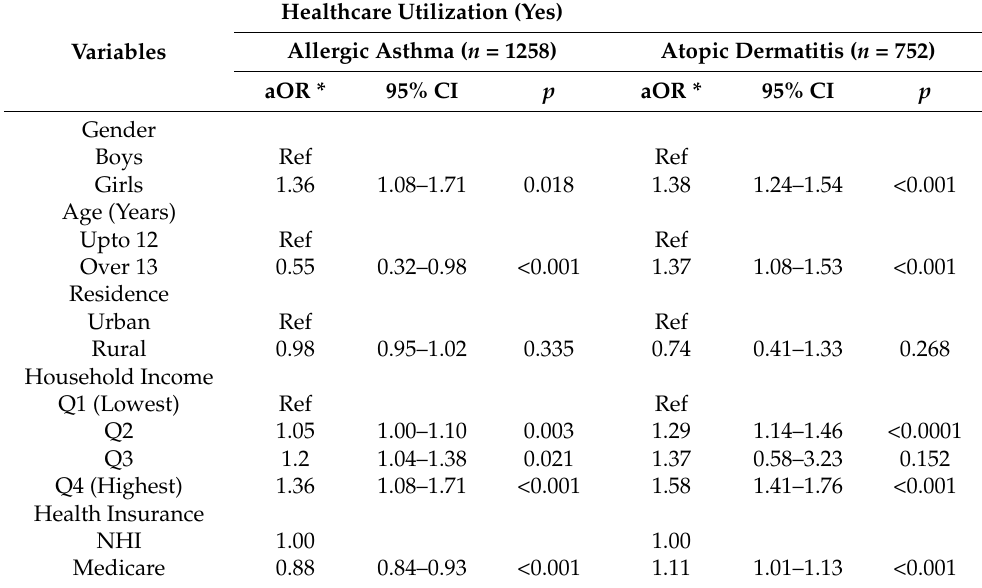
Table 2. Multivariate logistic regression analysis for factors associated with healthcare utilization in children with allergic diseases ( n =